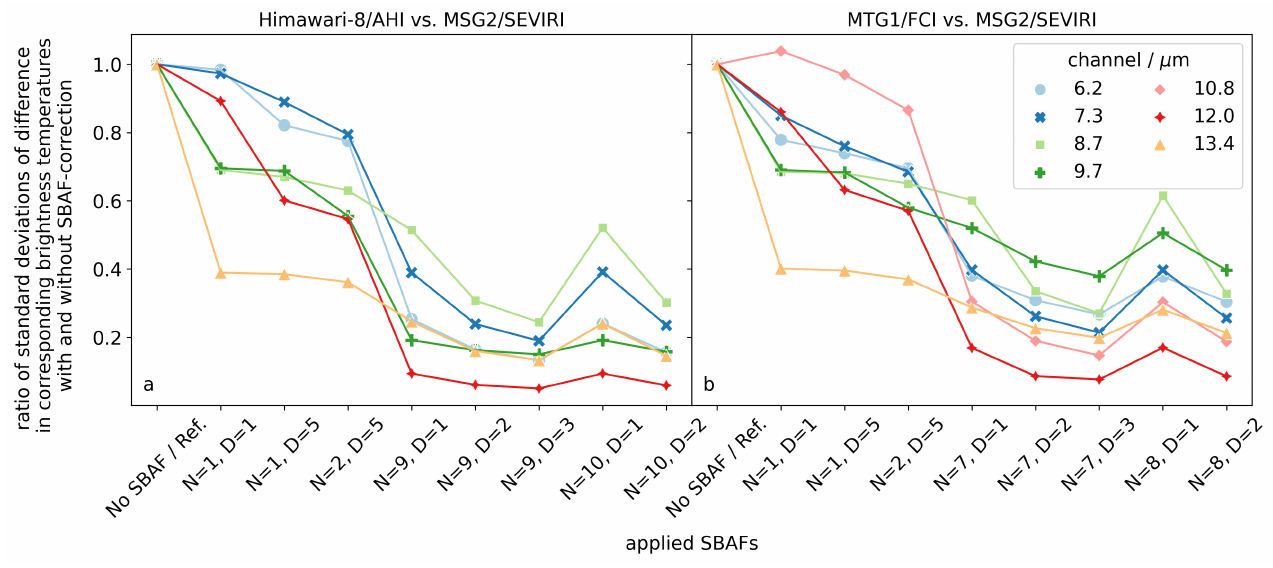
Figure 5. Visualization of the change of the standard deviation of the difference in equivalent brightness temperatures with SBAF-correction with respect to the case without it. Various SBAFs with different numbers of input variables N and degrees D are shown (see Section 2.4.3 for a detailed description). The MSG2/SEVIRI channel is color-coded. ( a ) shows the comparison of Himawari- 8/AHI and ( b ) of MTG1/FCI with respect to MSG2/SEVIRI, respectively. The 10.8 µ m channel is not shown for Himawari-8/AHI as it has two channels which are in the 10.8 µ m band for MSG2/SEVIRI, such that no clearly corresponding channel of the Himawari-8/AHI imager can be